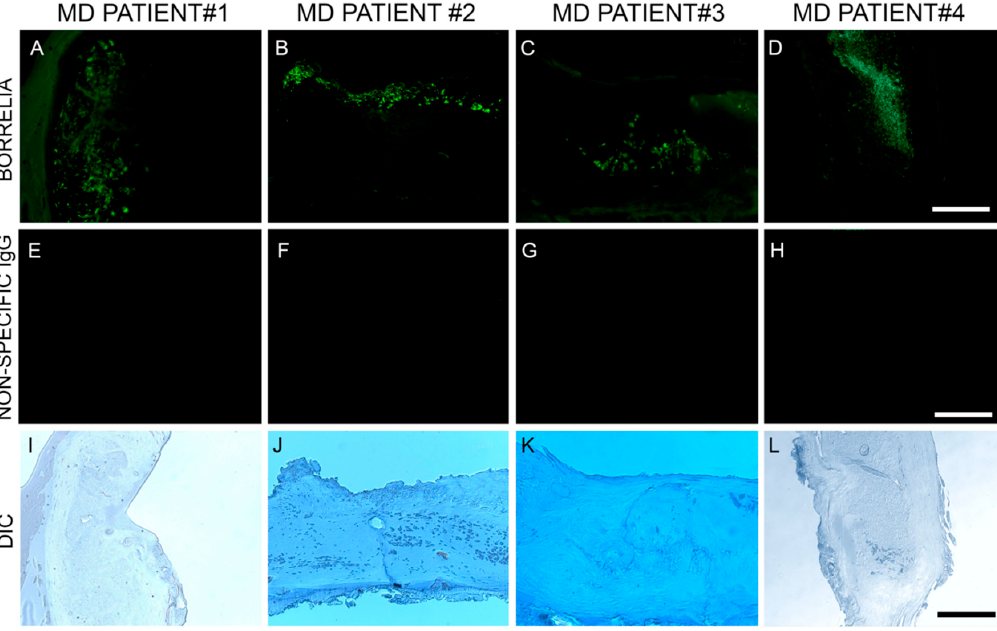
Figure 2. Representative immunohistochemical (IHC) images of Borrelia burgdorferi aggregates in skin sections of four MD subjects. IHC detection was performed as described in the Methods section. Panels labeled A–D show Borrelia burgdorferi aggregates in skin sections treated with anti- Borrelia monoclonal antibody (green). Panels labeled E–H show same sections treated with non-specific IgG antibody. Panels labeled I–L show the same sections under brightfield illumination with differential interference contrast (DIC) microscopy. Images were taken at 200× magnification. Scale bar = 100 µm.